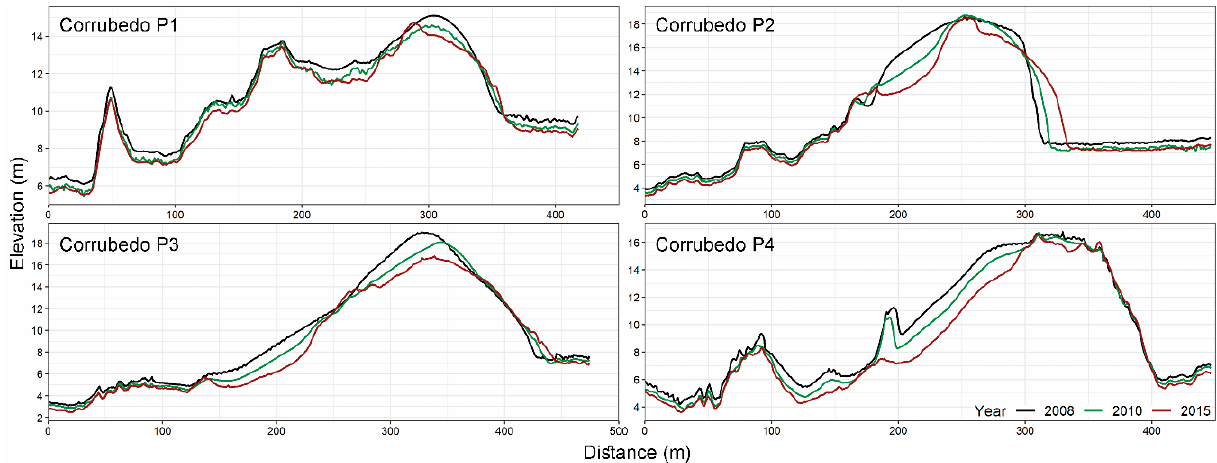
Figure 7. Topographic profiles in dune mobile sector between 2008 and 2015. The position of these profiles appears in Figure 1c in black color.